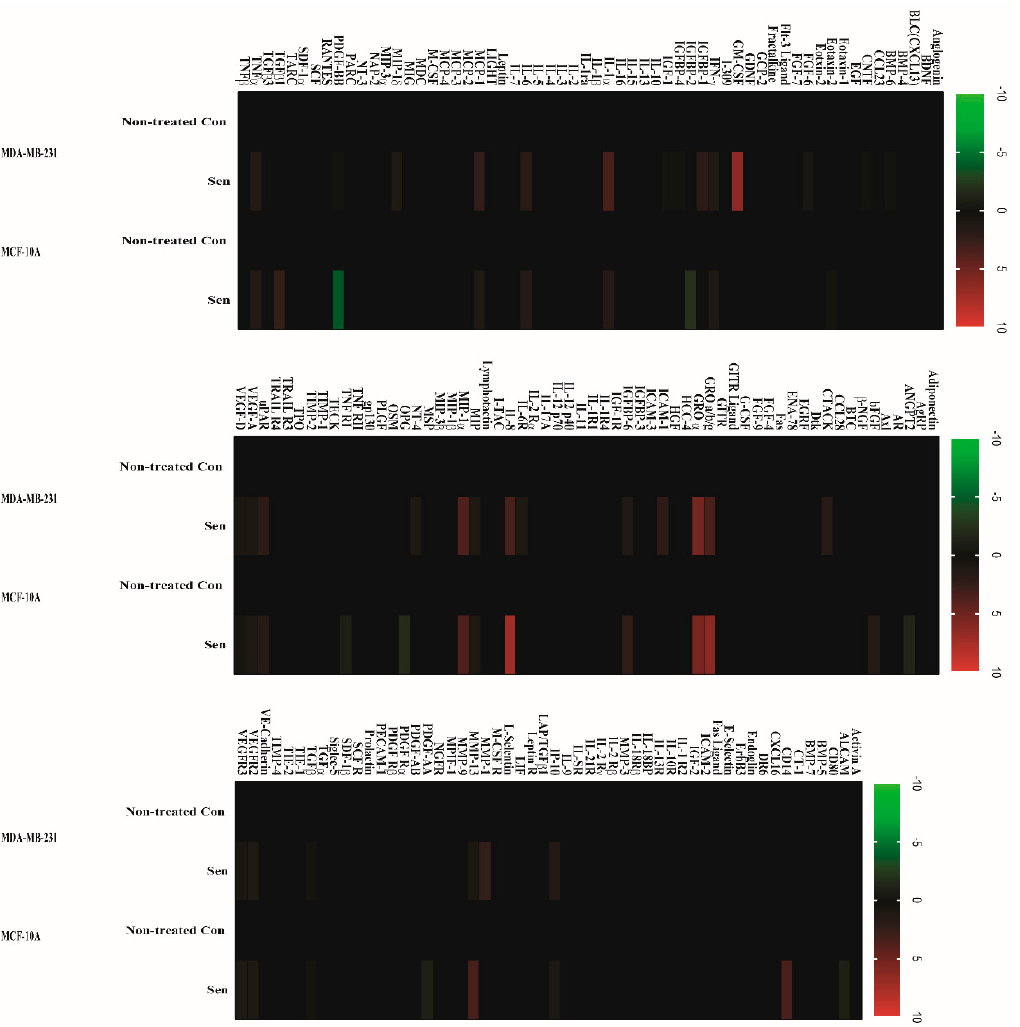
Figure 2. Senescent human breast cancer and normal cells developed SASP. Conditioned medium from nonsenescent (nontreated Con) or senescent (100 nM of doxorubicin exposure, Sen) MDA-MB-231 (A) and MCF-10A (B) cells were analyzed with human cytokine antibody arrays. Levels of each cytokine factor in untreated cells were arbitrary set to zero. Data shown represent log2-fold change in expression relative to untreated cells. Signals higher than the untreated control are shown in red; signals lower than the untreated control are shown in green.